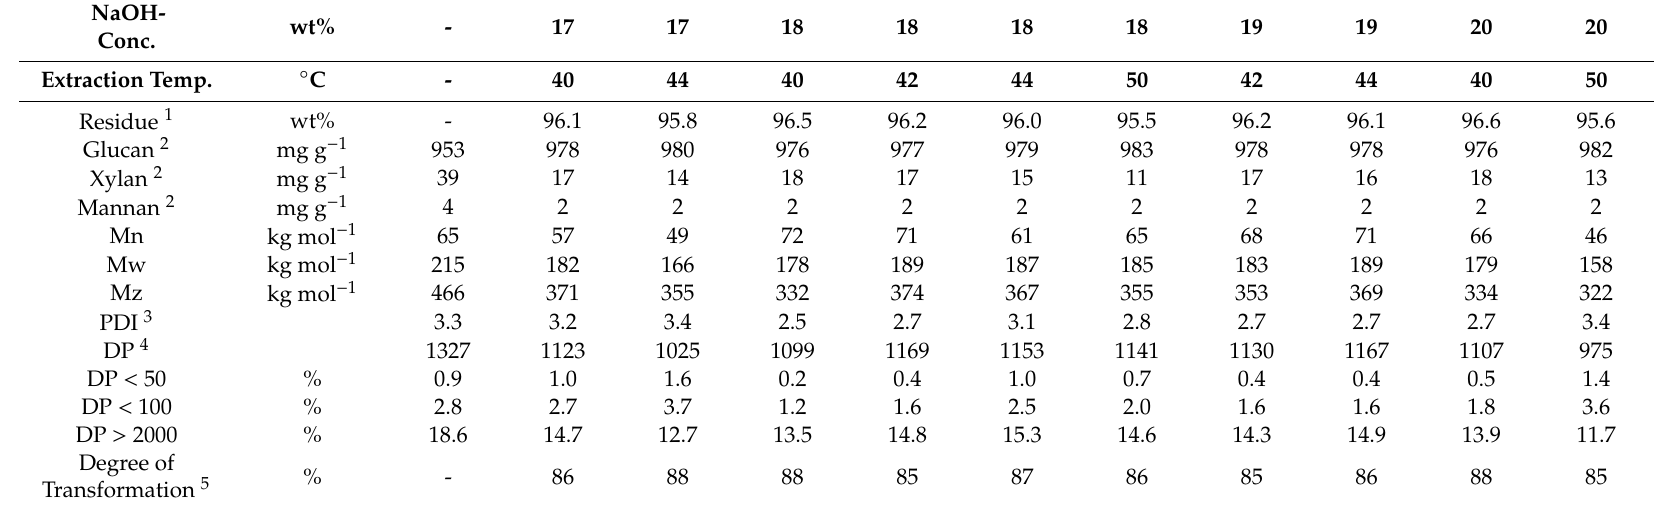
Table 1. Properties of the hardwood kraft dissolving pulp (-) investigated and experimental data for the residues after alkaline extraction at di ff erent alkali concentrations of aqueous NaOH and temperatures. NaOH- Conc. Extraction